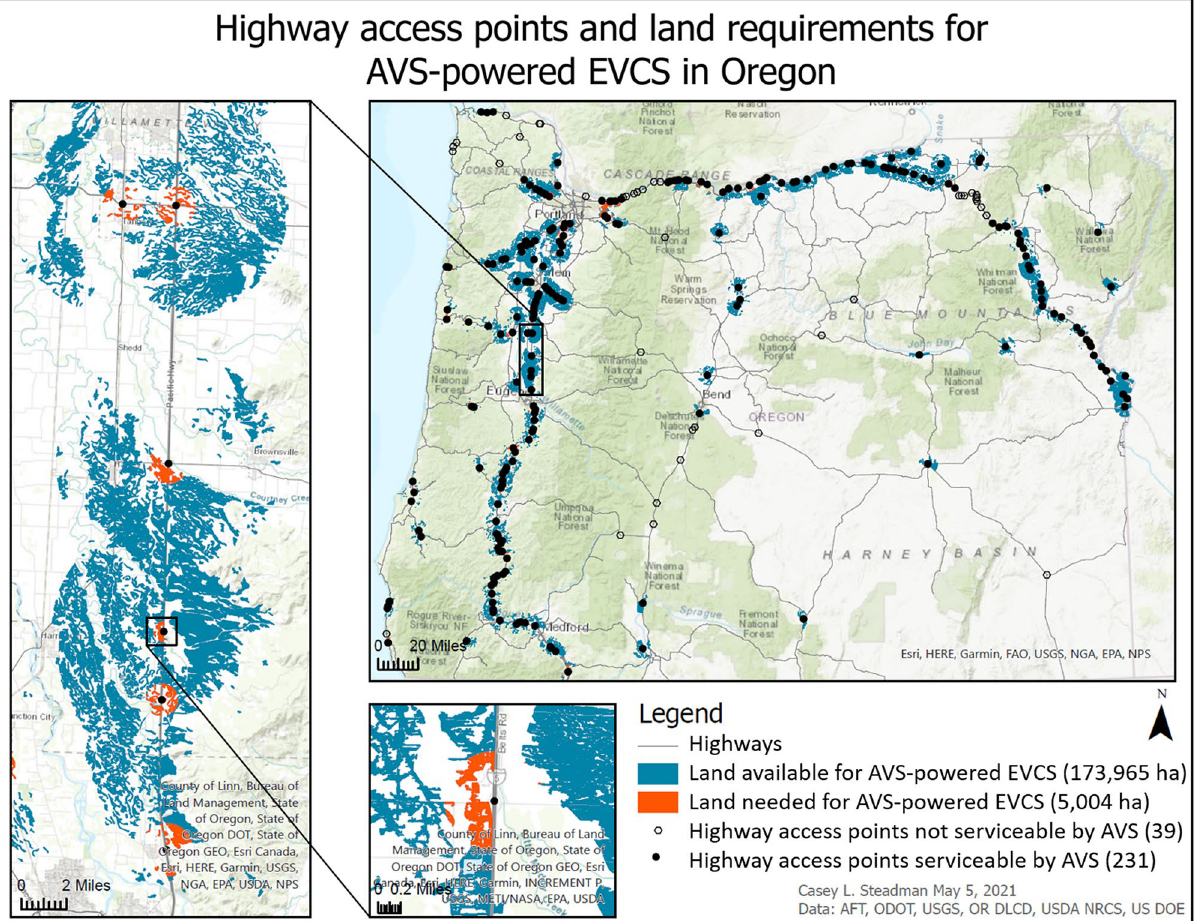
Figure 1. Model results with distribution and quantity of highway access points serviceable by AVS, highway access points not serviceable by AVS, land supply available, and portion of land supply needed to meet electricity demand at serviceable highway access